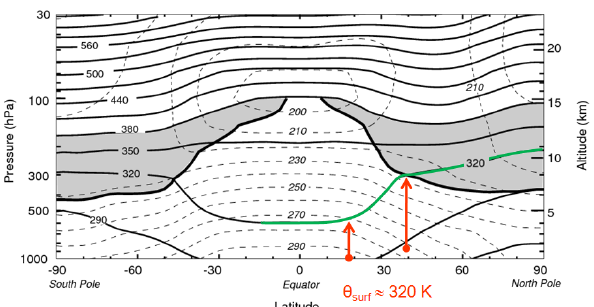
Fig. 2. Zonal and annual mean potential temperature (thin solid lines), absolute temperature (thin dashed lines), and tropopause (thick solid line). Shaded areas denote the lowermost stratosphere, whose potential temperature surfaces span the tropopause. Bases of red arrows mark the approximate latitude and altitude of African and Asian dust emission sources, which both reach surface potential temperatures of ∼ 320K. Figure adapted from Holton et al.